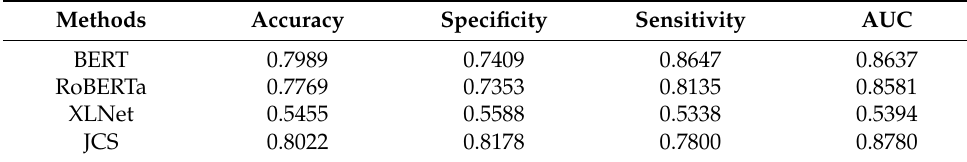
Table 4. Results of comparison with state-of-the-art